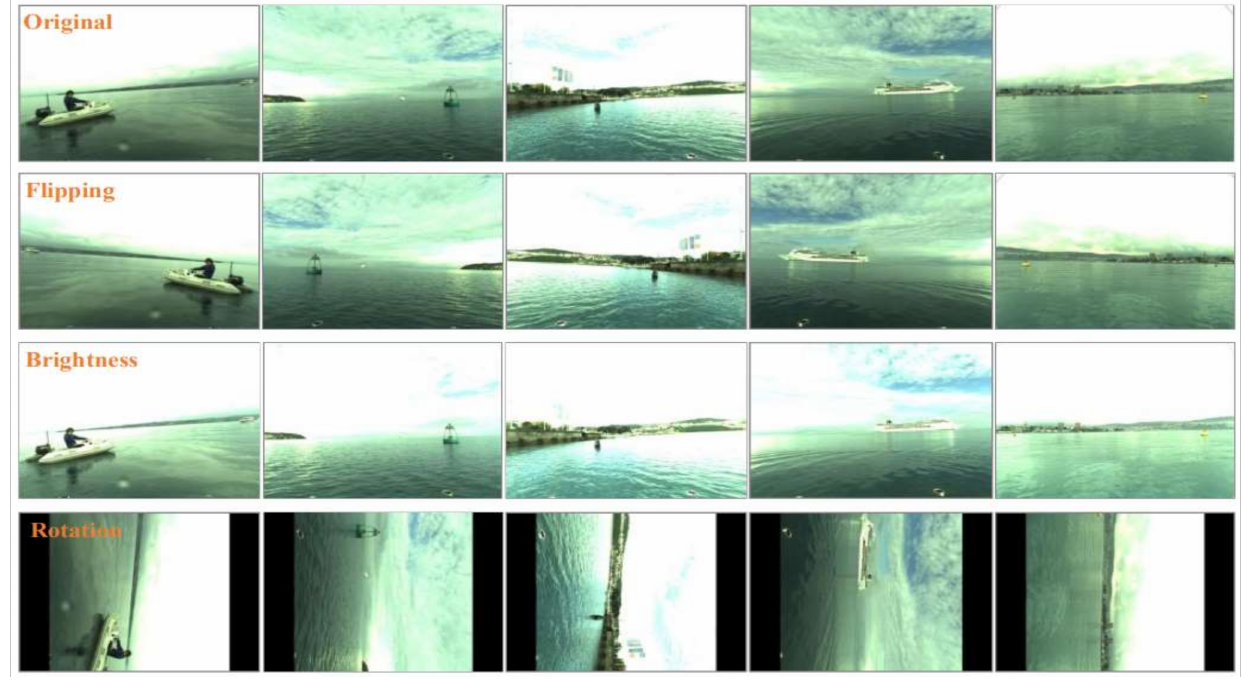
Figure 8. Data enhancement